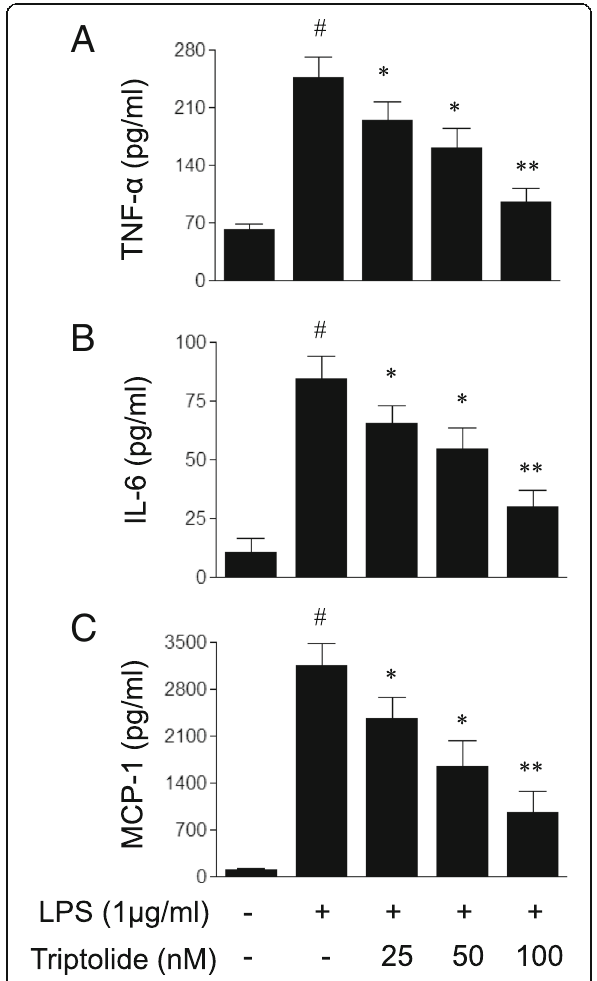
Fig. 2 The effects of triptolide on lipopolysaccharide (LPS)-induced production of pro-inflammatory ( a ) TNF- α , ( b ) IL-6 and ( c ) MCP-1 in human umbilical vein endothelial cells (HUVECs). HUVECs were treated with LPS (1 μ g/ml) in the presence or absence of triptolide (25, 50 or 100 nM) for 6 h. The ELISA assay was used to measure the concentrations of pro-inflammatory cytokines and chemokines in the culture medium. Data are expressed as the mean ± standard error of the mean. * p < 0.05 and ** p < 0.01, compared with LPS treatment alone. # p < 0.05, compared with the control